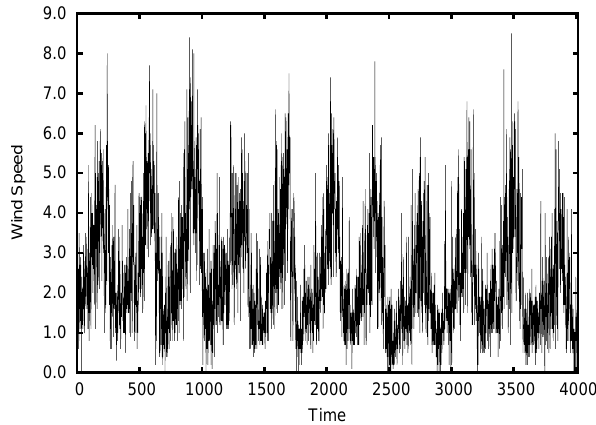
Fig. 1. Time series of the measured daily mean wind speed (DMWS) in